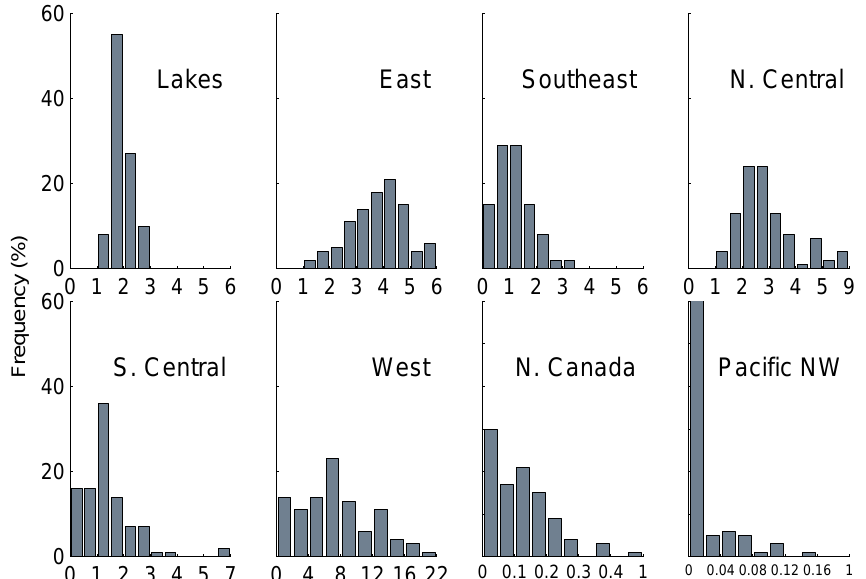
Fig. 9. Histograms of inverse emissions scaling factors for emissions from the Great Lakes and from forest fires by domain. See Fig. 2 for map of lake emissions and Fig. 3 for map of forest fire emissions. (Note that factors for Alaska and WRF D2 are always 0.)